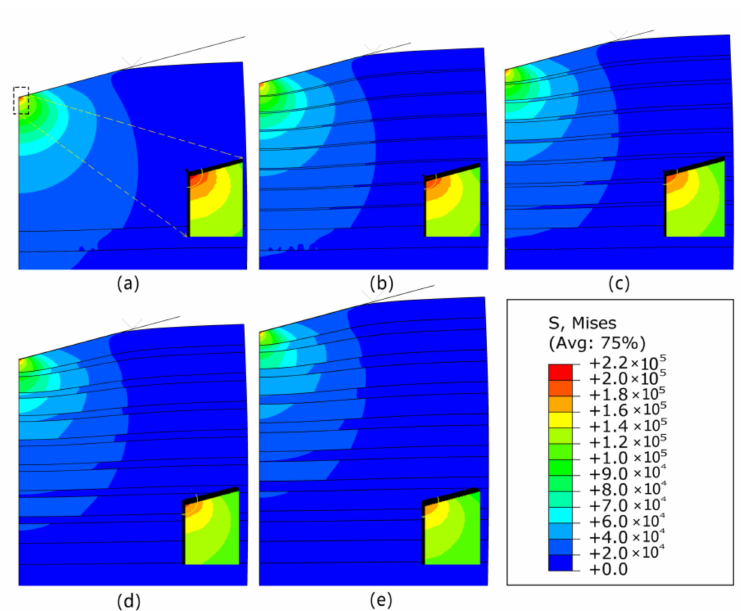
Figure 9. Contours of the Von Mises stress generated in TiAlSiN monolayer coatings and TiAlSiN / Ti multilayer coatings ( a ) #S1 (Ti-0 nm), ( b ) #M2 (Ti-25 nm), ( c ) #M3 (Ti-50 nm), ( d ) #M4 (Ti-100 nm), ( e ) #M5 (Ti-150 nm), ( e-x ) the partial enlarged image of ( e ), the stress unit is in Pa.